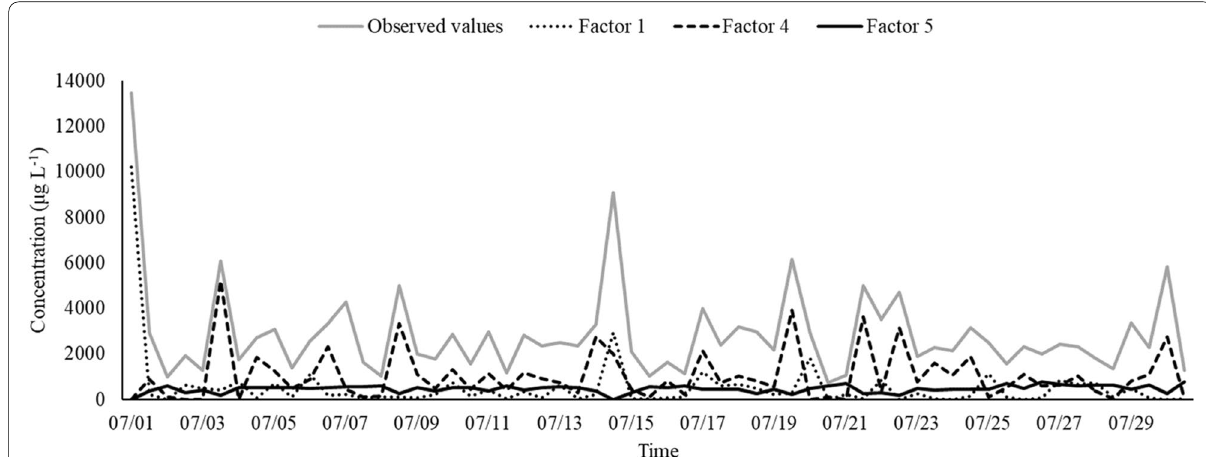
Fig. 2 Measured total metal elemental concentrations and the contributions of Factors 1, 4, and 5 over time